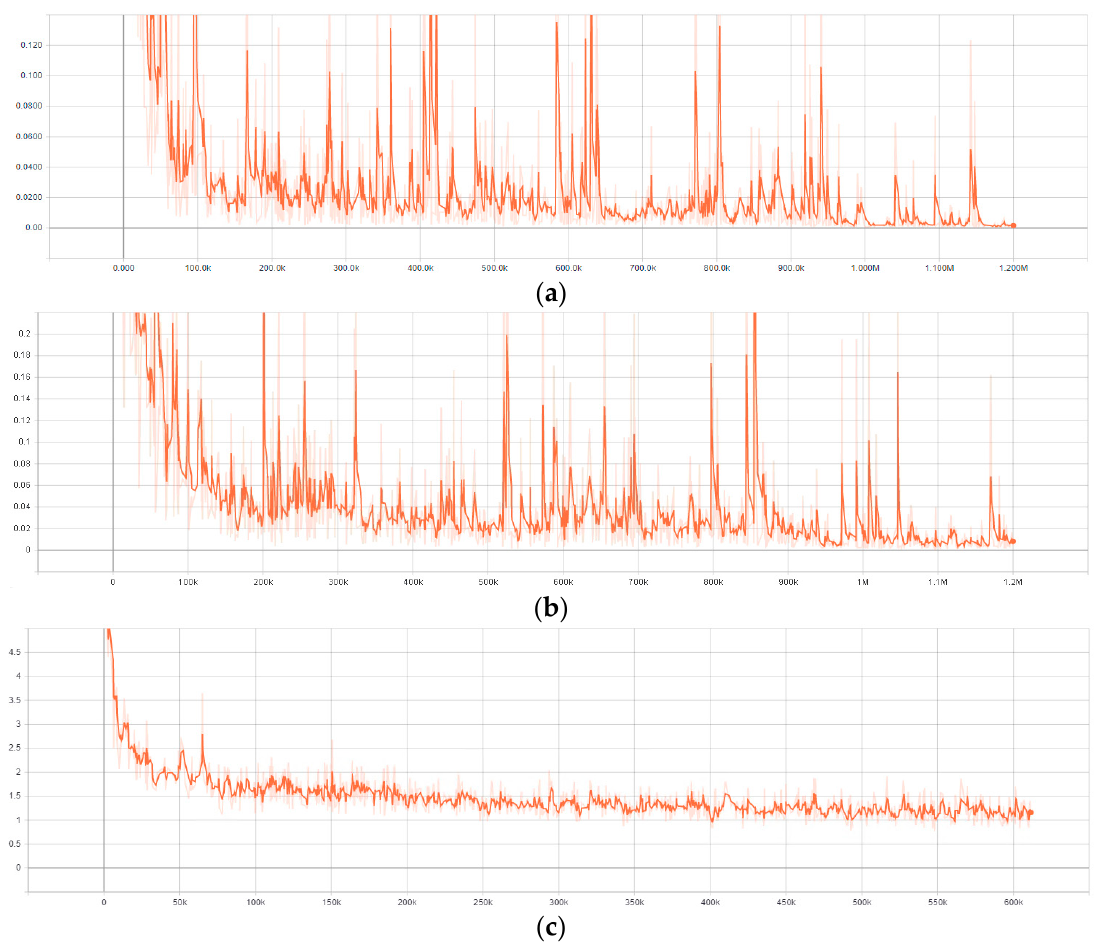
Figure 6. Loss function of ( a ) Faster R-CNN with ResNet_101 ( b ) R-FCN with ResNet_101 ( c ) SSD with ResNet_101.